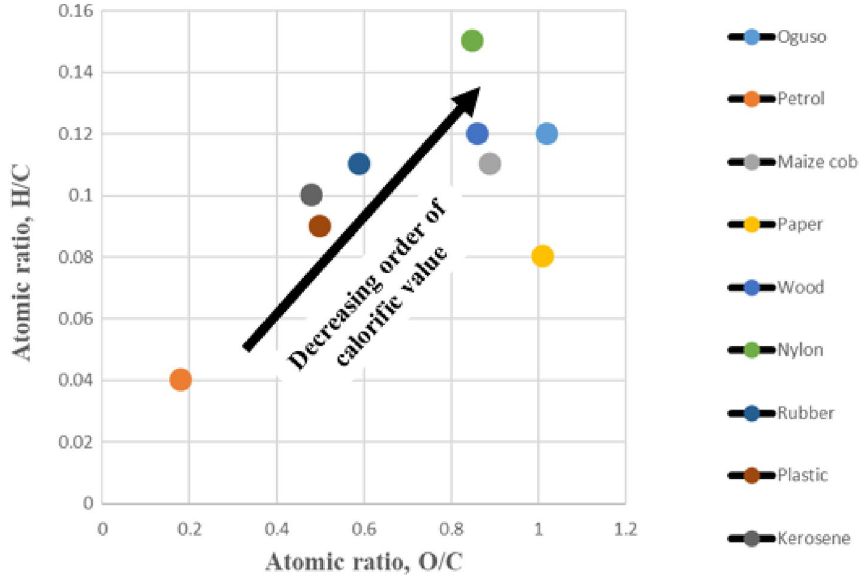
Figure 6. Van Krevelen plot of the ignition